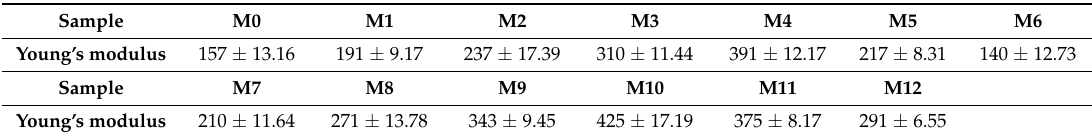
Figure 12. Effects of the CNF and LCN content on the tensile strength and breaking elongation of the membranes. Table 4. Young’s modulus of membranes (MPa). Table 4. Young’s modulus of membranes